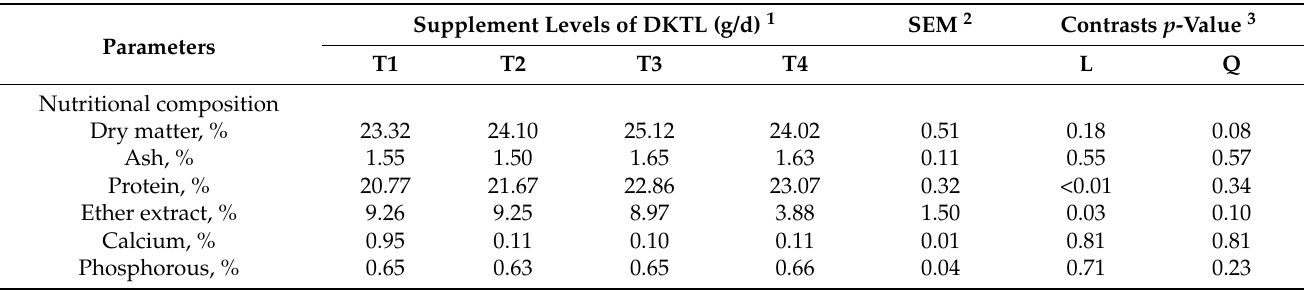
Table 6. Effects of Kratom leaves supplement on chemical composition and physical properties of Longissimus dorsi muscle of fattening goats.